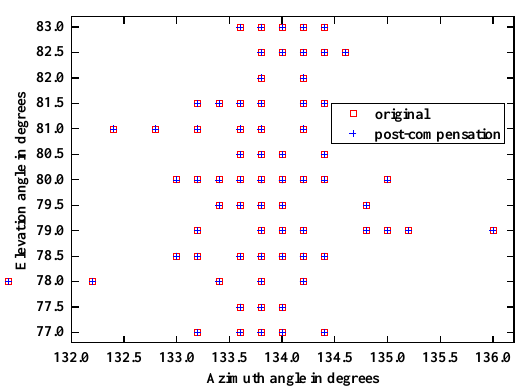
Figure 16. Azimuth-elevation angle estimation results comparison between strong target signal before and after compensation.